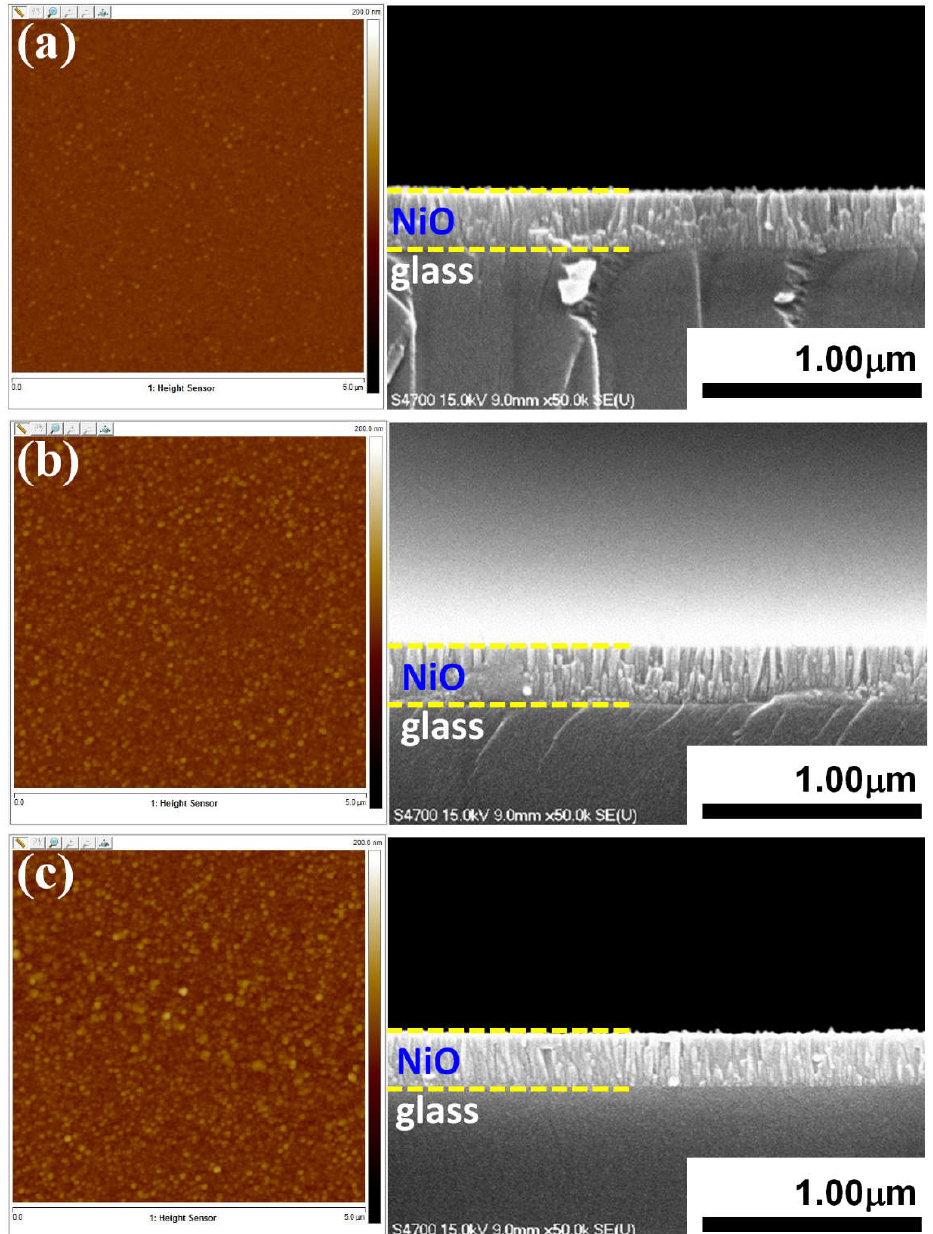
Figure 2. ( left ) AFM surface micrographs (5 × 5 μm 2 ) of NiO films deposited at various substrate temperatures: ( a ) 300 °C, ( b ) 400 °C and ( c ) 500 °C. ( right ) The corresponding cross-sectional SEM images.